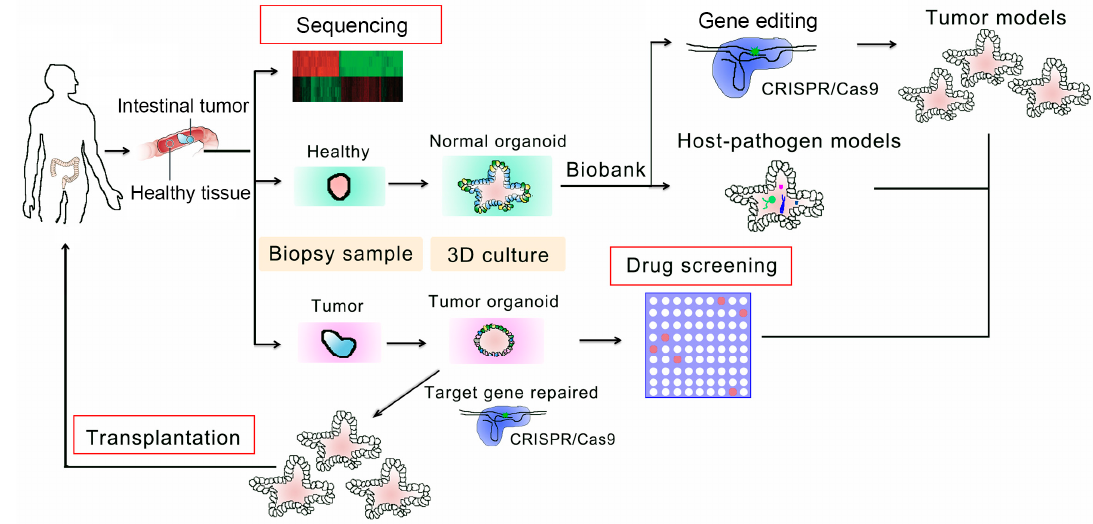
Figure 1. Applications of organoid technology for drug screening and therapy in personalized medicine. Gene mutations in patients’ tissues can be identified by genome or transcriptome sequencing. Meanwhile, the biopsy materials can be cultured in Matrigel to form organoids, which can be used to establish disease models via gene editing and co-culturing with niche cells and pathogens. The modified tumor organoids can be utilized for drug screening and testing. Gene mutations in organoids can be corrected by clustered regularly interspaced short palindromic repeats/CRISPR-associated 9 (CRISPR/Cas9)-mediated gene editing for transplantation.